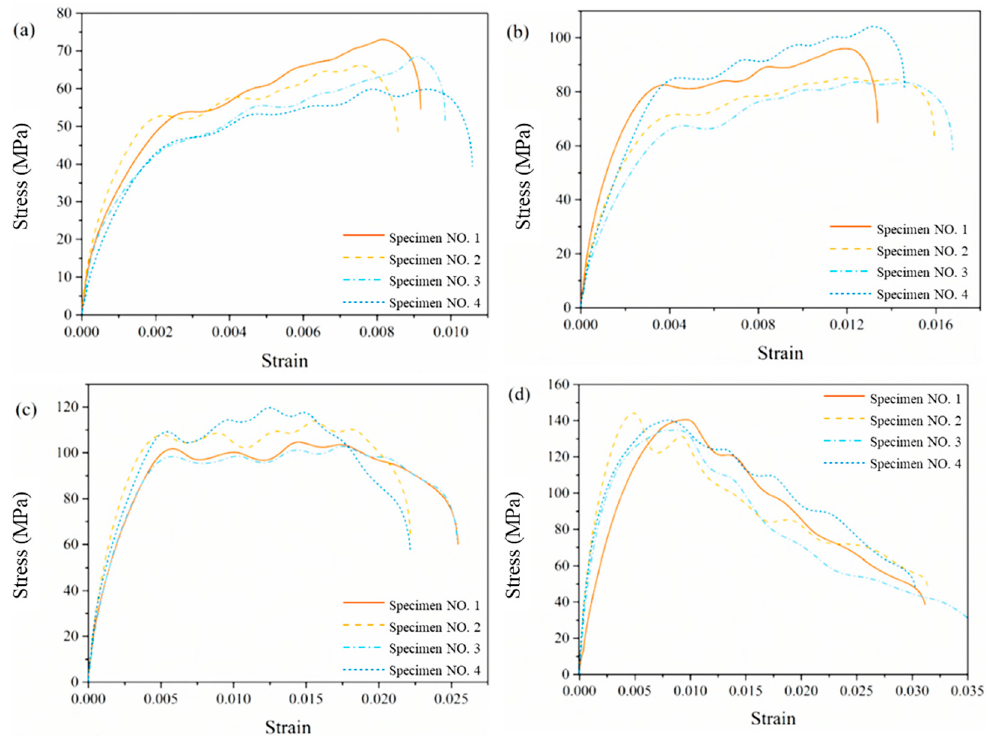
Figure 6. Pulse signal with different impact velocities: ( a ) 12.2 m/s, ( b ) 18.8 m/s, ( c ) 25.0 m/s, ( d ) 29.2 m/s.